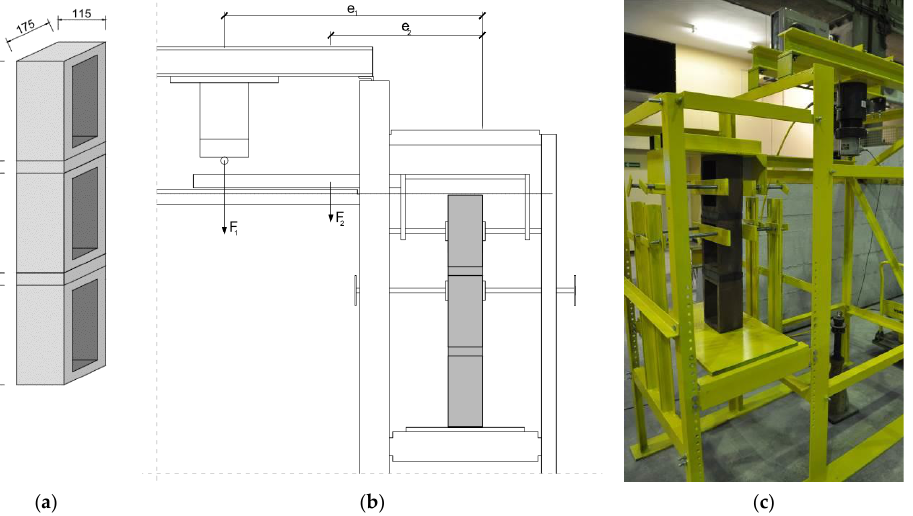
Figure 3. Experimental setup for bond wrench test: ( a ) shape and overall dimensions of the test specimens; ( b ) static scheme; ( c ) view of the specimen prepared for testing.